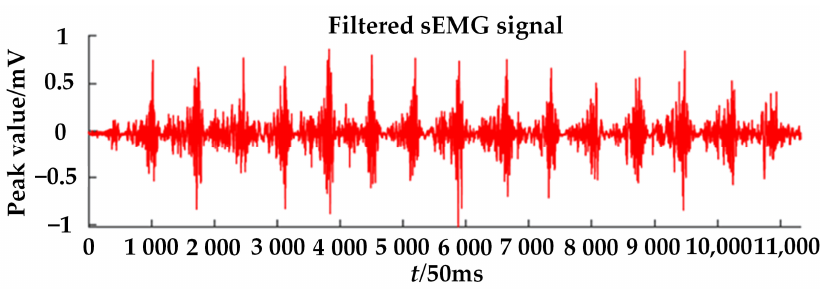
Figure 16. Filtered sEMG signal.